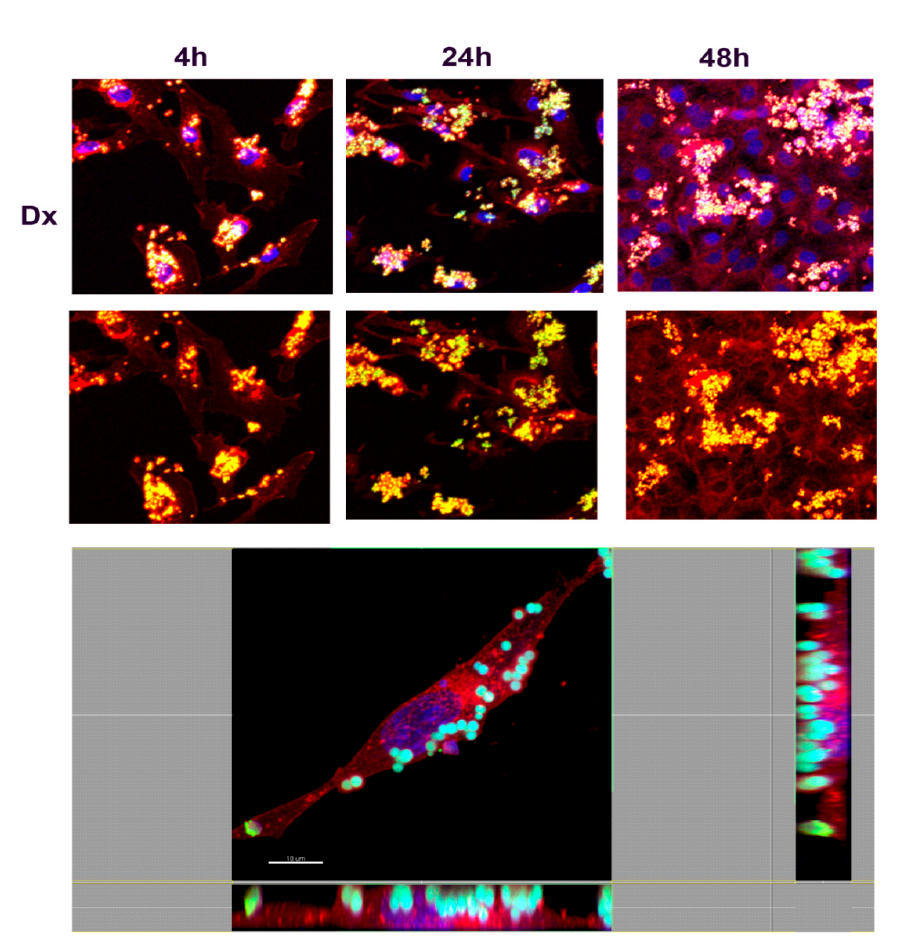
Figure 9. Confocal laser scanning microscopy images of dextran NMP cellular uptake. (TOP panel) Representative images of fibroblasts treated with FTIC-labeled dextran (DX) NMPs (green) for indicated time (4 h, 24 h, and 48 h). The cells were stained with WGA conjugated to Texas Red (red) and counterstained with Hoescht 33258 to visualize the nucleus (blue). Scale bars, 30 µ m. (BOTTOM panel) Confocal X-Y, X-Z, and Y-Z sections in max intensity projection mode (MIP modality). Side panels present z -sections along the x and y planes and show the 3D distribution of cells, confirming that DX-NMPs are clearly attached to the cell on the outside of the membrane after 4 h incubation. Scale Bar, 10 μ m.